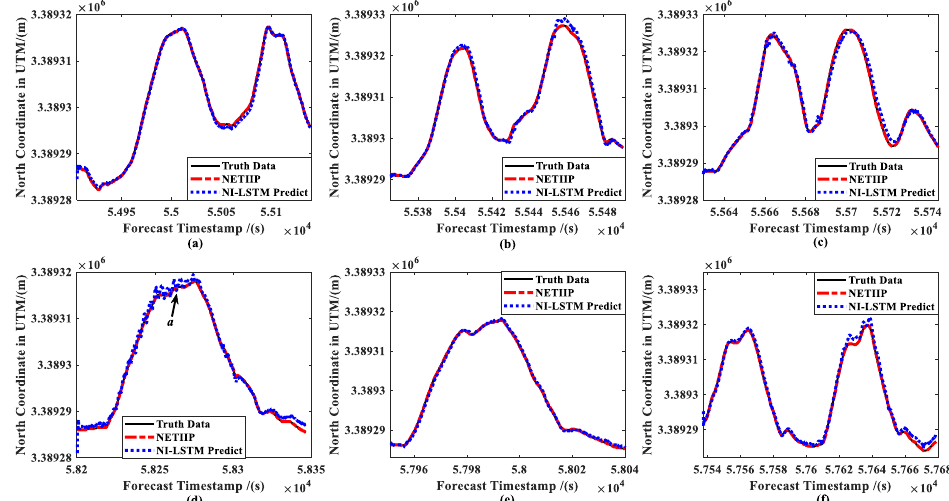
Figure 12. Comparison of ship position predictions: ( a ) slow speed of MRM, ( b ) medium speed of MRM, ( c ) high speed of MRM, ( d ) slow speed of ANM, ( e ) medium speed of ANM, and ( f ) high speed of ANM.